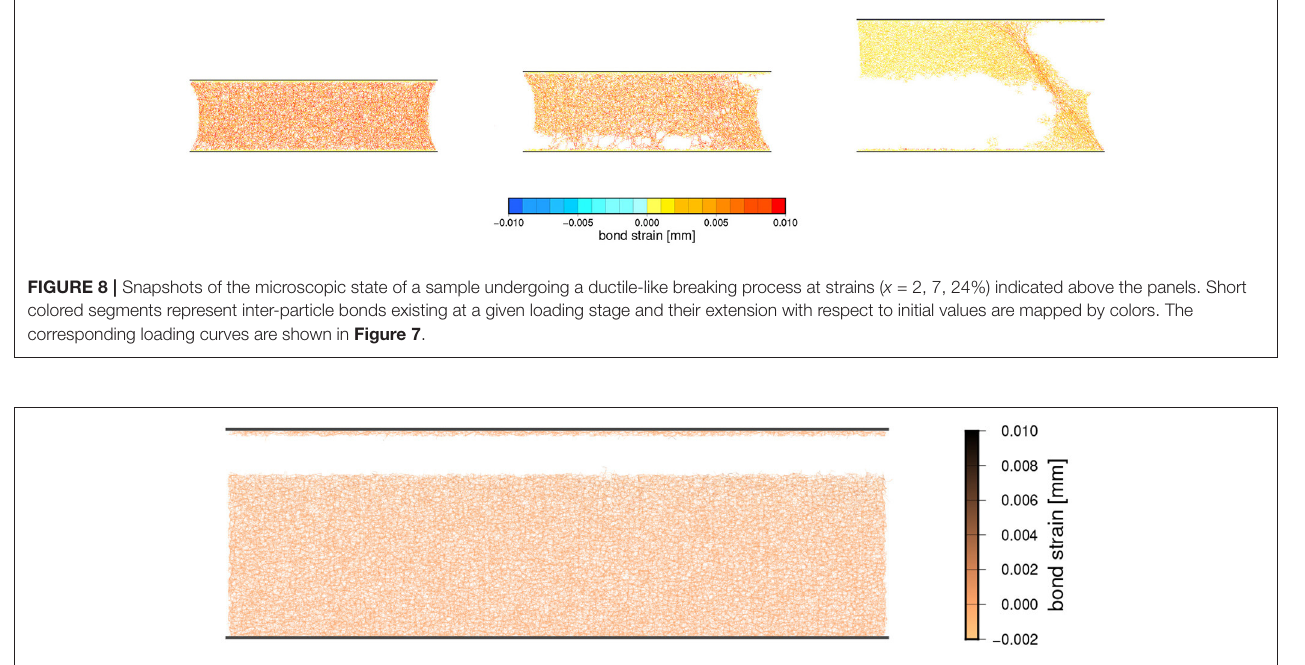
FIGURE 9 | Snapshots of a microscopic state of a sample undergoing a pure brittle cleavage-like breaking process. Short colored segments represent the inter-particle bonds existing at a given loading stage and their extension with respect to the initial values are mapped by colors. The corresponding loading curves are shown in Figure 10